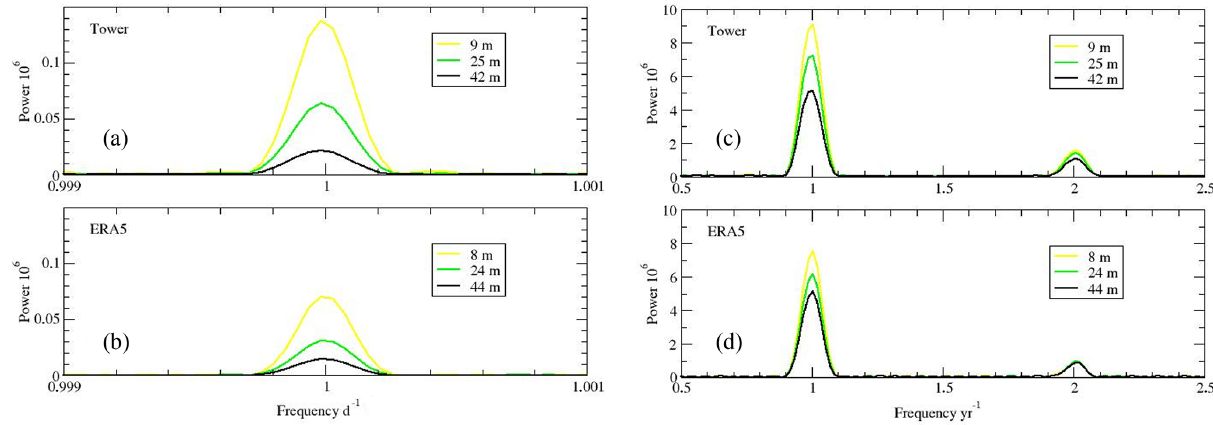
Figure 14. Harmonic analysis of the temperature time series near diurnal (a, b) and annual/semi-annual (c, d)